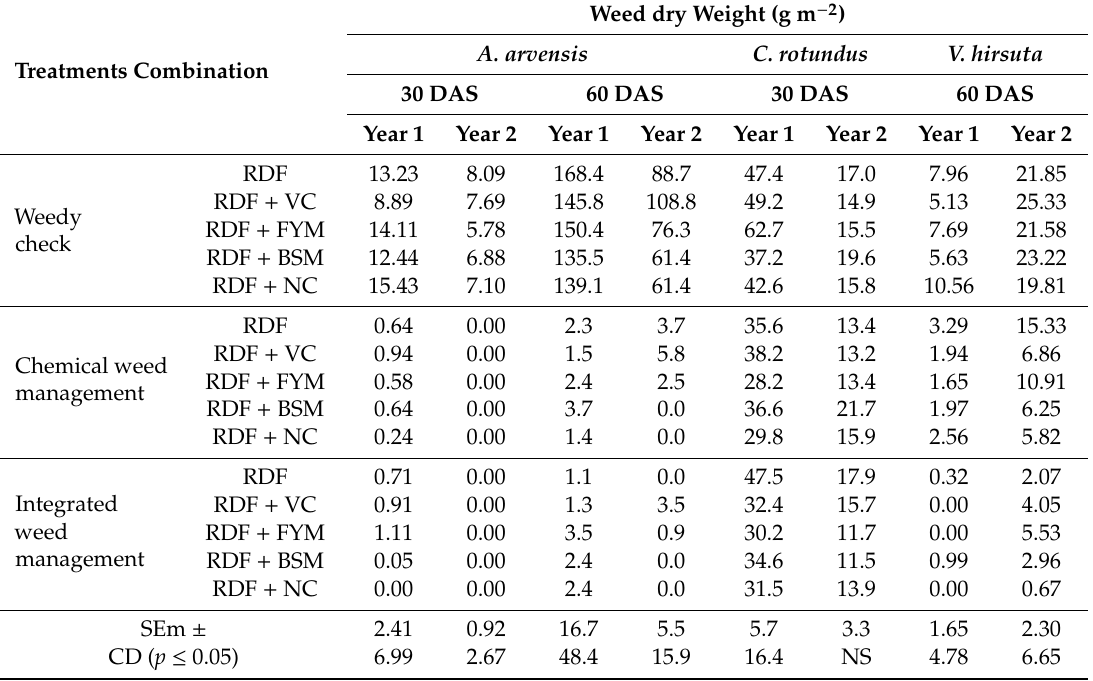
Table 2. Interaction e ff ect of di ff erent nutrient managements and weeding regimes on weed dry weight (g m − 2 ) in hybrid